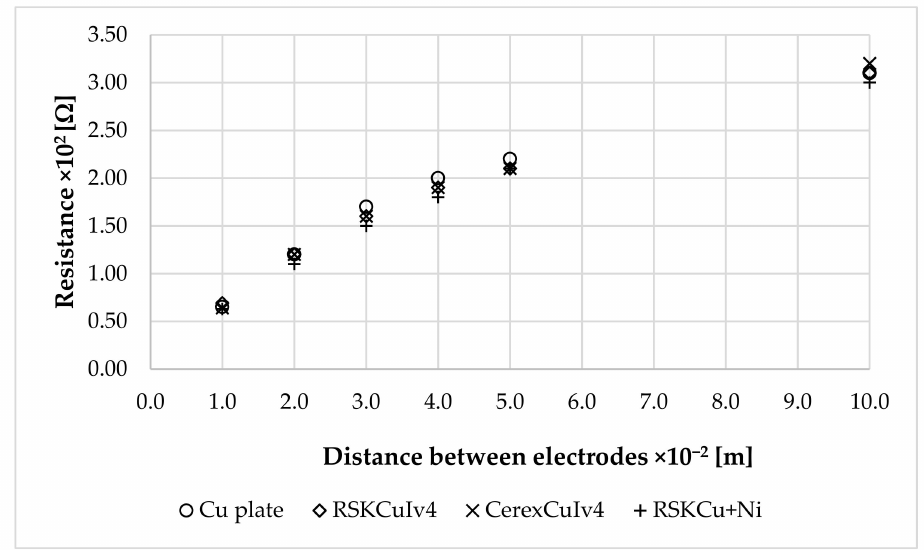
Figure 14. Measurement results of the resistance values in relation to the distance between